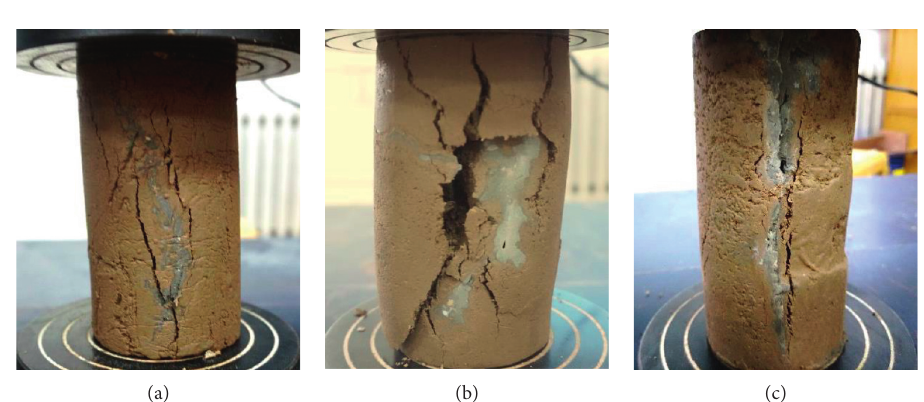
Figure 5: Fracturing slurry veins in the reinforced loess.